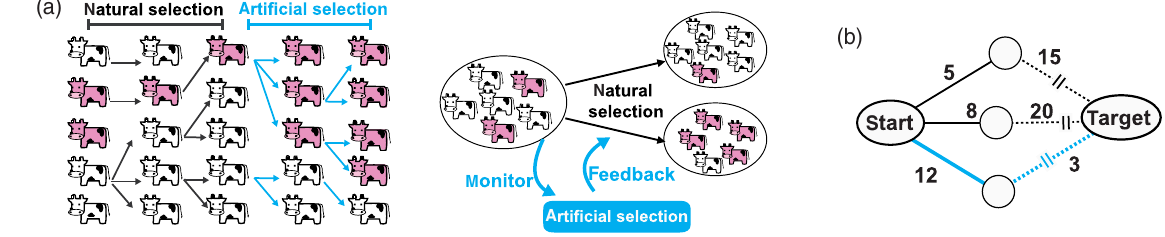
FIG. 1. Artificial selection as an optimal stochastic adaptive control strategy. (a) Artificial selection is an external intervention to select for a desired trait (i.e., pinkness of cows) in a population, which is otherwise not favored by natural selection. Artificial selection should be viewed as an optimal feedback control, whereby monitoring a stochastically evolving population informs the intervention protocol to optimally bias breeding and reproduction over generations. (b) The schematic graph shows different paths with indicated costs for a system to evolve from a start to a target state. Bellman ’ s principle of optimality states that at each step an optimal decision is made, assuming that the following steps are also determined optimally. Although the first step (full line) of the blue path is more costly compared to the others (dotted lines), its cumulative cost is minimum, and hence, it should be chosen as the optimal path. This decision can be made best recursively, known algorithmically as dynamic